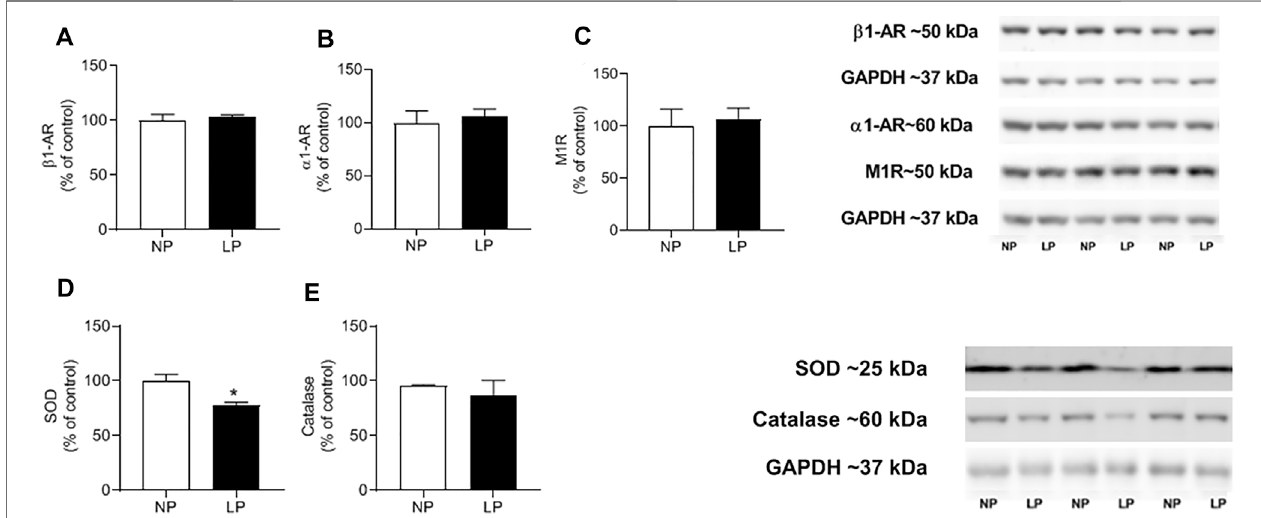
FIGURE 6 | Cardiac protein expression. Mean value of western blot in beta-1 receptor (Anti-B1) (A) , alpha-1 receptor (Anti- α 1) (B) , muscarinic-1 receptor (Anti- M1) (C) and superoxide dismutase enzymes (SOD) (D) , activity ofcatalaseenzymes(CAT) (E) and representative immunoblots are show on the up-right corner, n = 4 – 7 animals per group. NP, normal protein diet; LP, low protein diet. Values presented as mean ± SD *** p < 0.001, ** p < 0.01, and * p < 0.05 indicate statistical signi fi cance (Student ’ s T test).